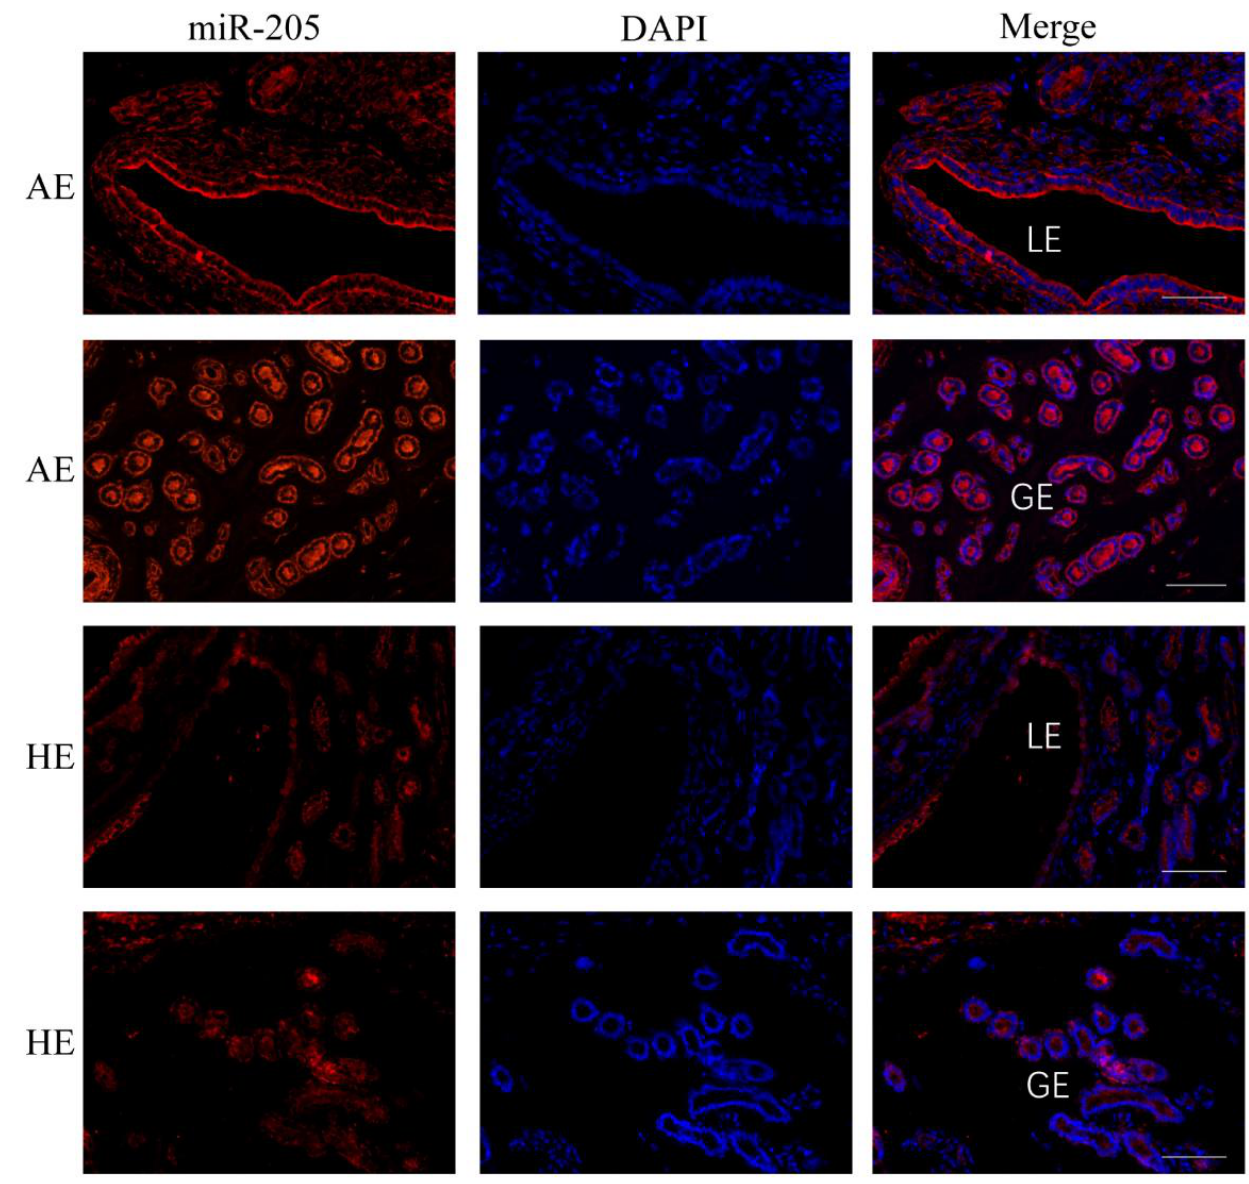
Figure 8. Fluorescence in situ hybridization (FISH) localized expression of miR-205 to the uterine section samples in the two statuses of arresting endometrium (AE) and healthy endometrium (HE). At 28 days of pregnancy, the expression level of miR-205 was abundantly expressed in AE luminal epithelium and glandular epithelium, and at the same time, it was slightly expressed in HE tissues. Hybridization buffer without probes was used as a negative control group (NC; (Figure S1, Supple- mentary Materials)). Legend: LE, luminal epithelium; GE, glandular epithelium. Scale bar 100 um.